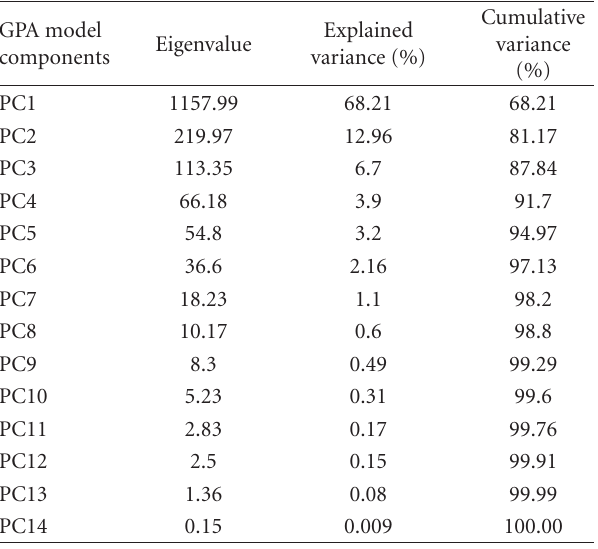
Table 5: The 14 components of the GPA, their Eigenvalues, and the percentage of explained variance of the GPA